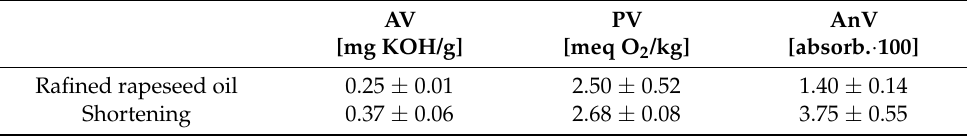
Table 8. Quality parameters of fresh fats.